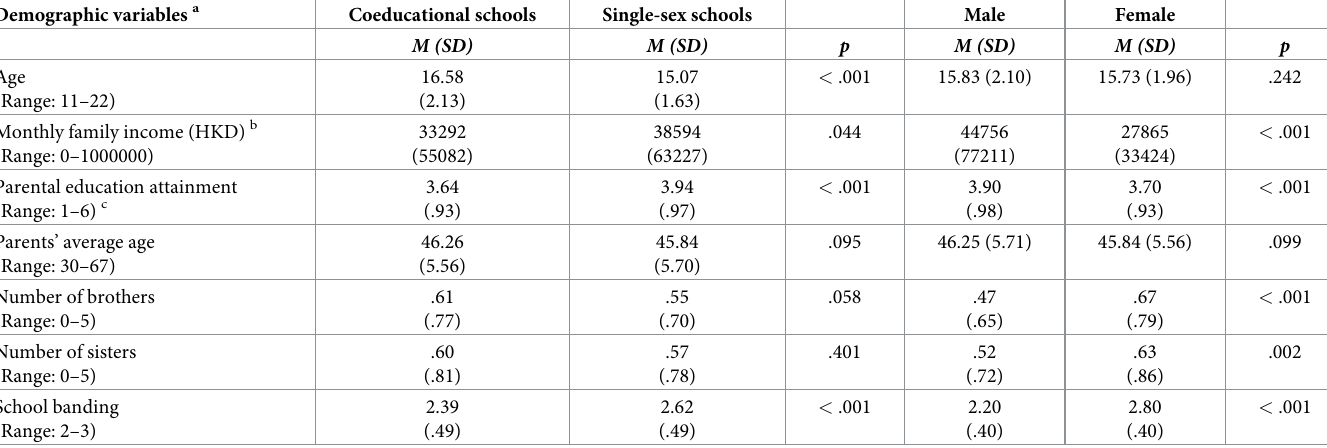
Table 1. Participant characteristics by school type and student gender (Study 1: High school